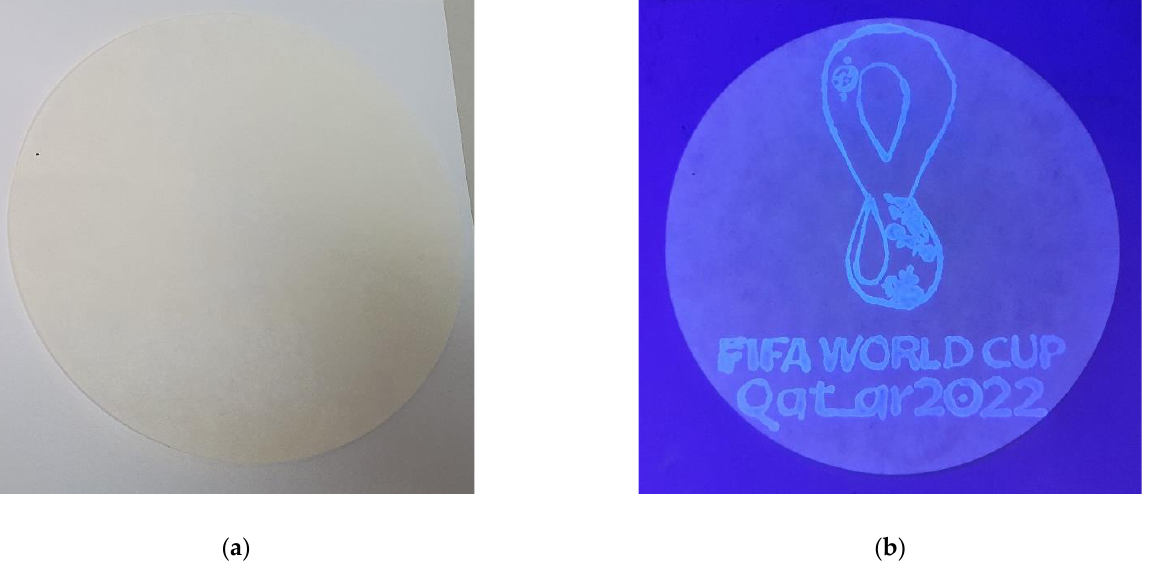
Figure 14. 3APS-coated filter paper with writing by the Al(III) solution under normal light ( a ) and